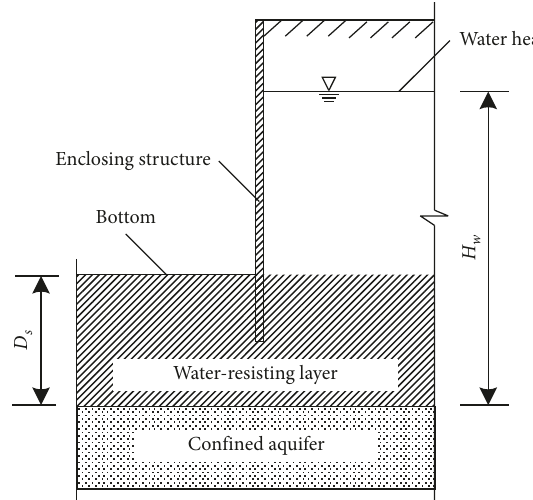
Figure 1: The calculation model of base inrush stability in current